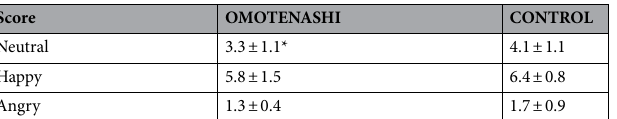
Table 1. The score on favor rating tests for Neutral, Happy, and Angry stimulus conditions in OMOTENASHI and CONTROL. Data are presented as the mean and standard deviation for each group. *p < 0.05: comparison with